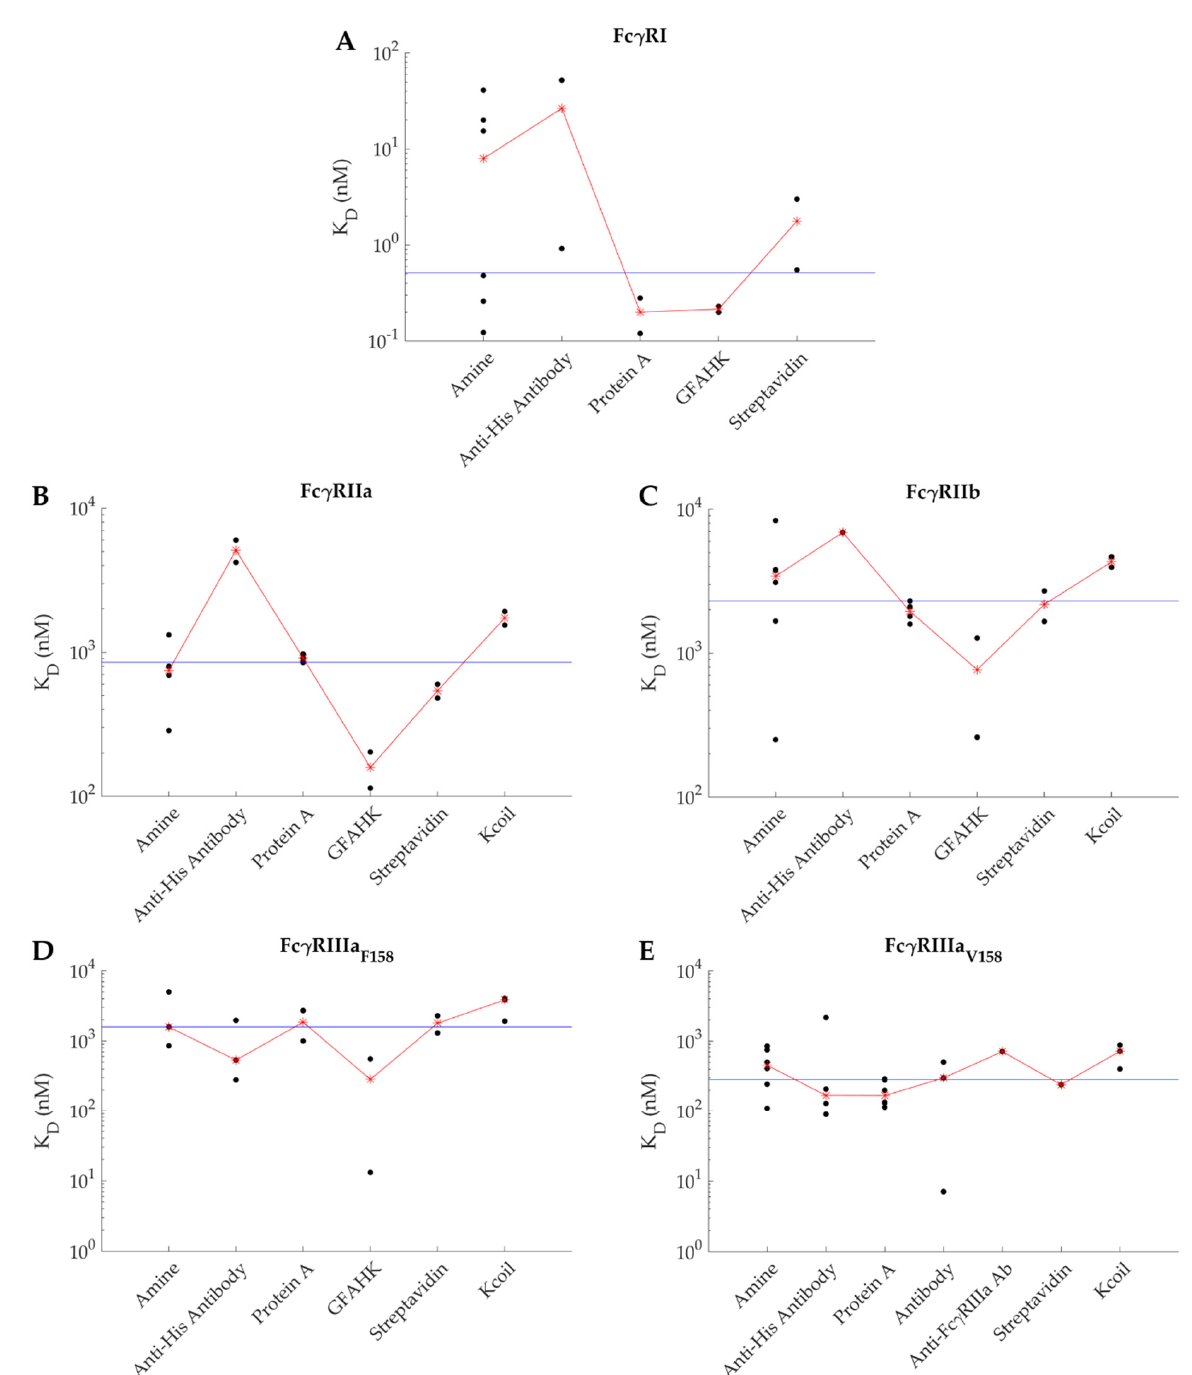
Figure 4. Affinities reported in the literature between IgG and ( A ) Fc γ RI, ( B ) Fc γ RIIa, ( C ) Fc γ RIIb, ( D ) Fc γ RIIIa F158 and ( E ) Fc γ RIIIa V158 depending on the immobilization strategy. GFAHK stands for Goat F(ab (cid:48) )2 anti-human kappa antibody. The blue line represents the median of all values combined, while the red line crosses the median point values specific to each immobilization